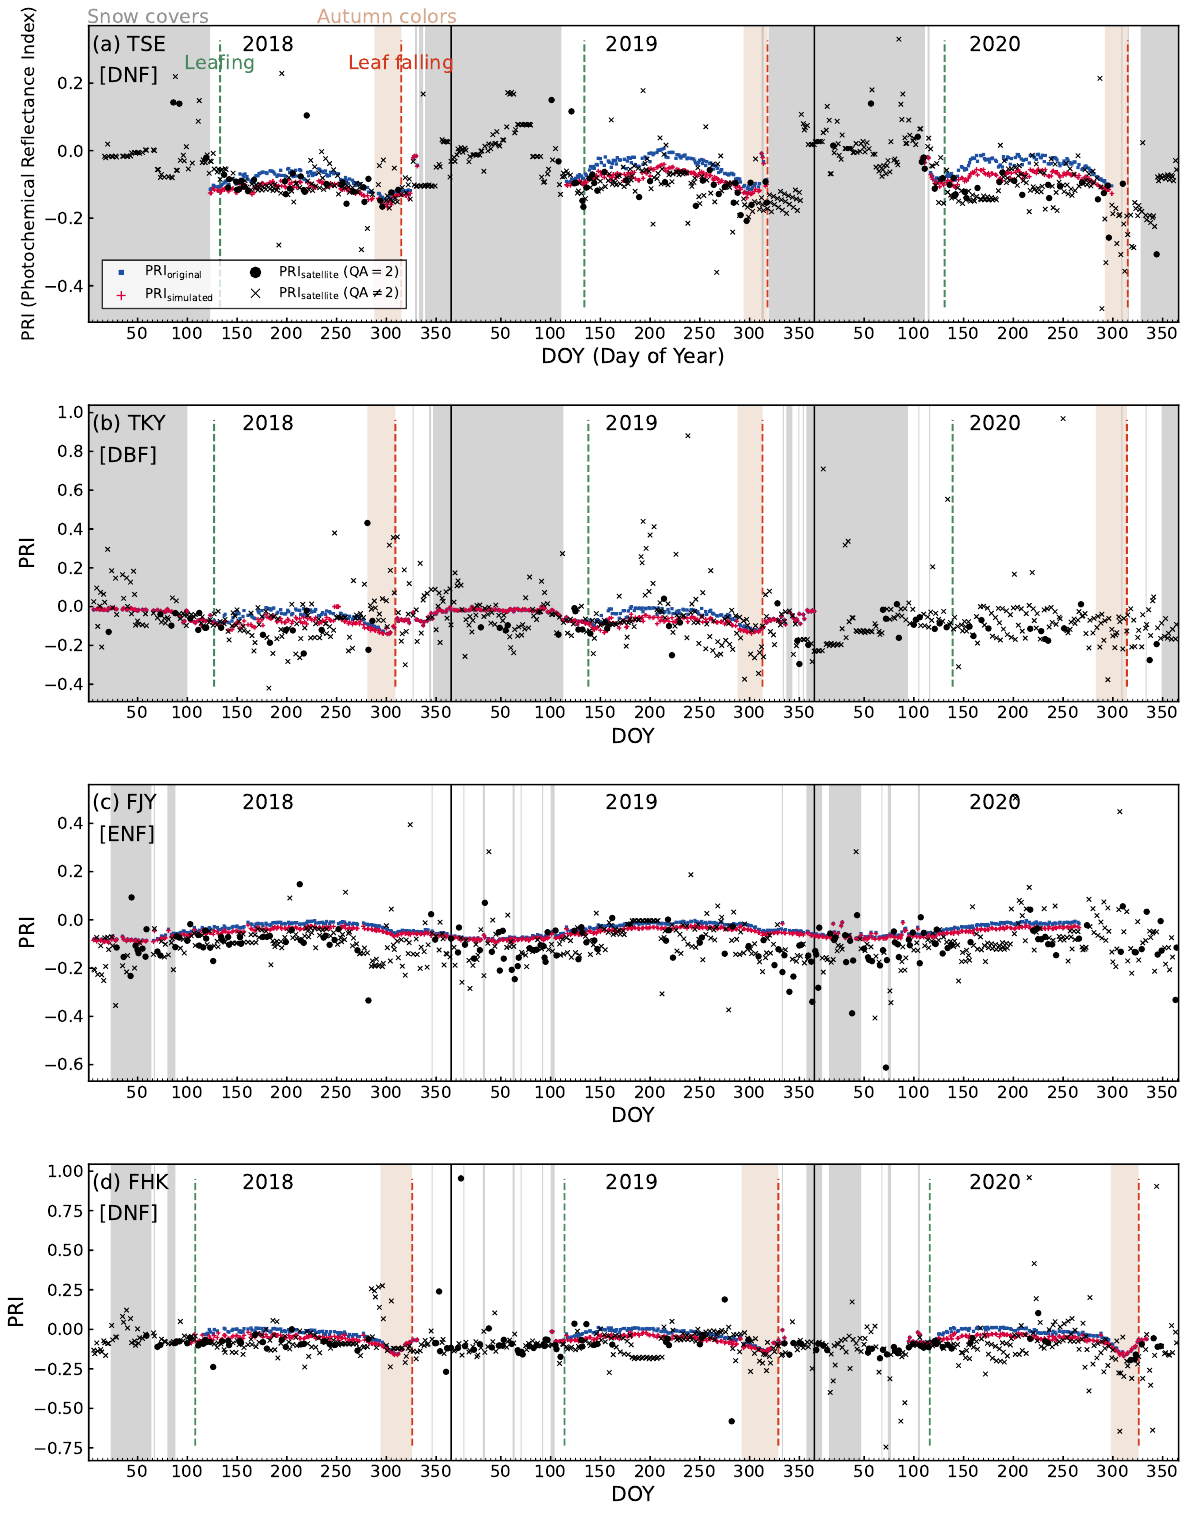
Figure 7. Time series of PRI original , PRI simulated , and PRI satellite from 2018 to 2020 at the four study sites. The blue square is PRI original , the red plus is PRI simulated , the black circle is PRI satellite not screened with the quality assessment (QA) flag, and the black cross is PRI original screened with the QA flag. The gray bands are snow seasons, the orange bands are autumn colors seasons, the green dotted lines are leafing timings, and the red dotted lines are leaf falling